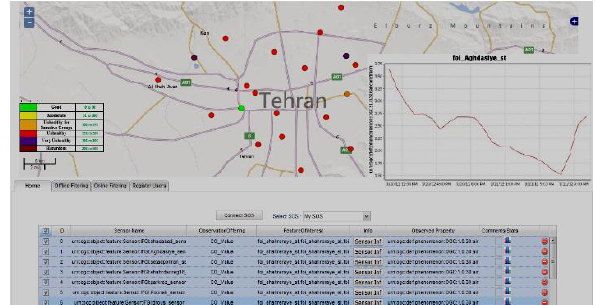
Figure 3. Sensor web geoportal for implementing monitoring air pollution